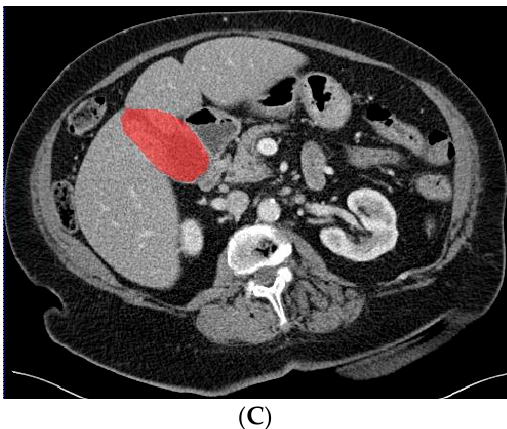
Figure 2. Axial CT slice ( A ) with an example of gallbladder cancer (histopathologically proven adenocarcinoma, encircled in ( B )) and subsequent segmented gallbladder ( C ).